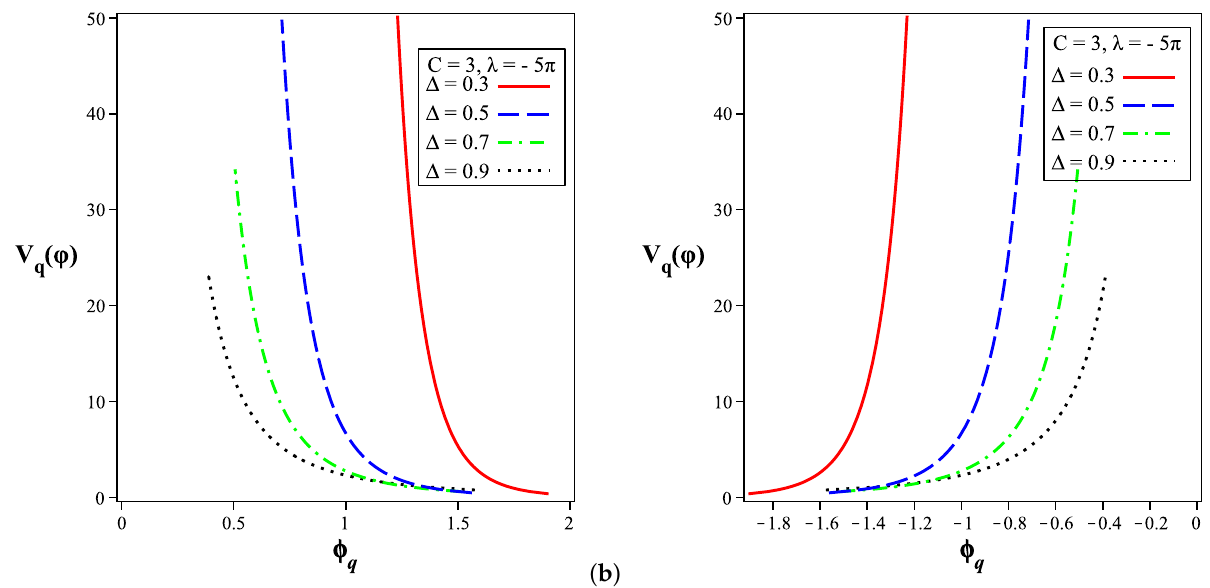
Figure 3. The behaviour of the Barrow holographic quintessence potential ( V q ( φ ) ) versus the scalar field ( φ ): ( a ) ( φ q ) is positive and ( b ) ( φ q ) is negative; here, C = 3 and λ = − 5 π